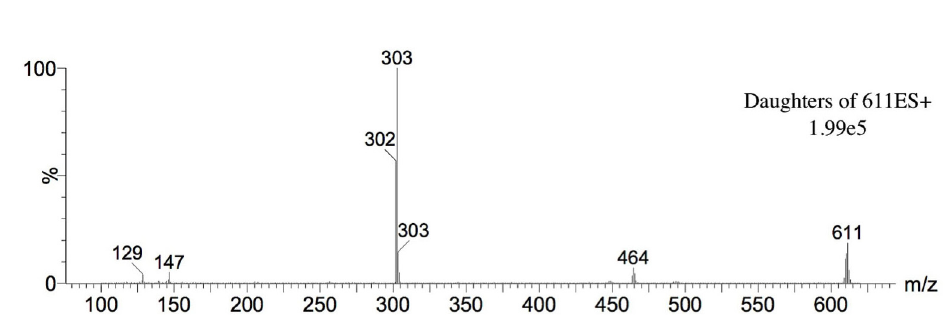
Fig 10. Mass spectrum on ESI positive mode under MRM monitoring for molecular ion m/z